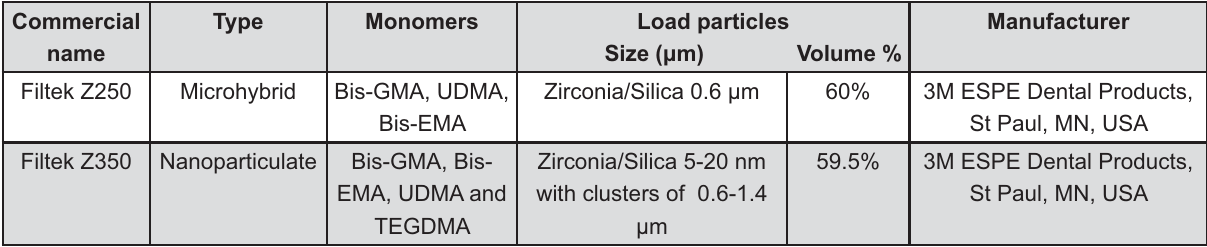
Figure 1- Tested